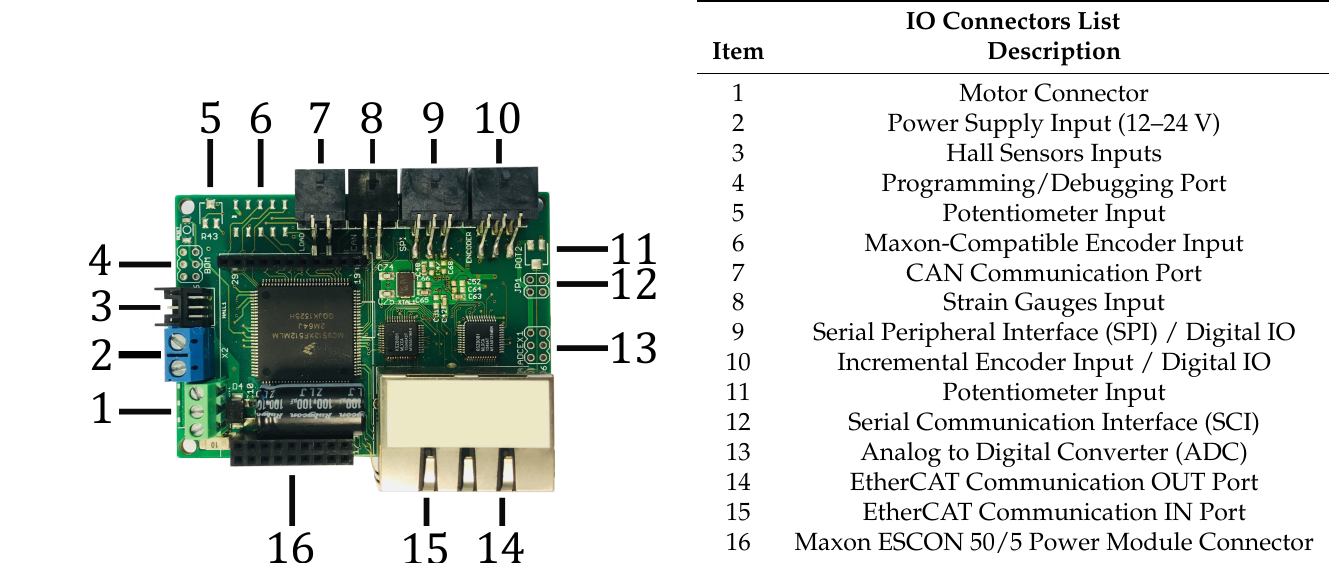
Figure 8. Low-level control module included in SMARCOS. The board allows connection to a wide variety of sen- sors/encoders through the different communication ports listed in the Figure. The control of a (BL)DC motor is possible with the optional interfacing of a Maxon ESCON 50/5 power module. For more versatility, the board is EtherCAT